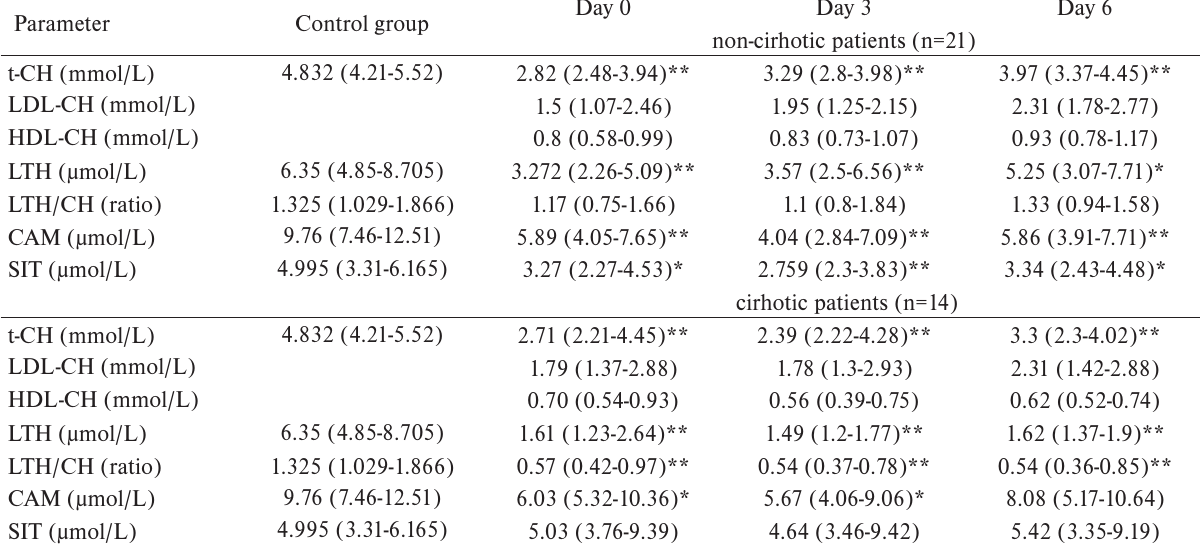
Table 3. Plasma concentration of lipid and sterols with or without cirrhosis. Comparison with control group. Parameter